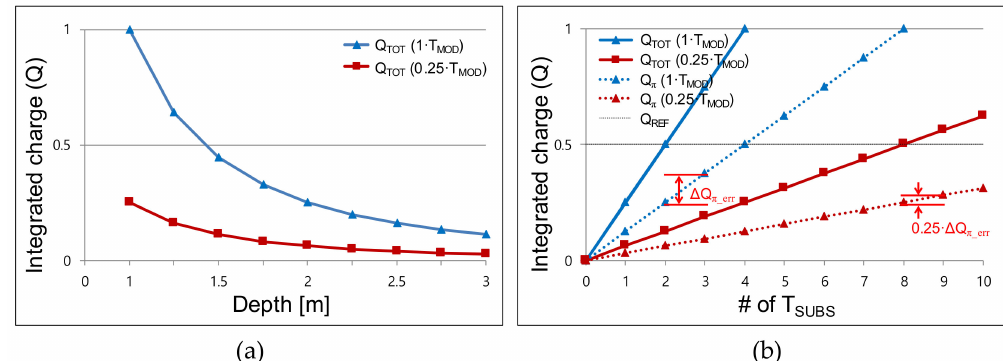
Figure 3. Requirement of the adaptive modulation time with multiple T SUB s: ( a ) integrated total charge ( Q TOT ) according to the distance with the adaptive modulation time; ( b ) integrated Q TOT and Q π according to the number of T SUB s with the adaptive modulation